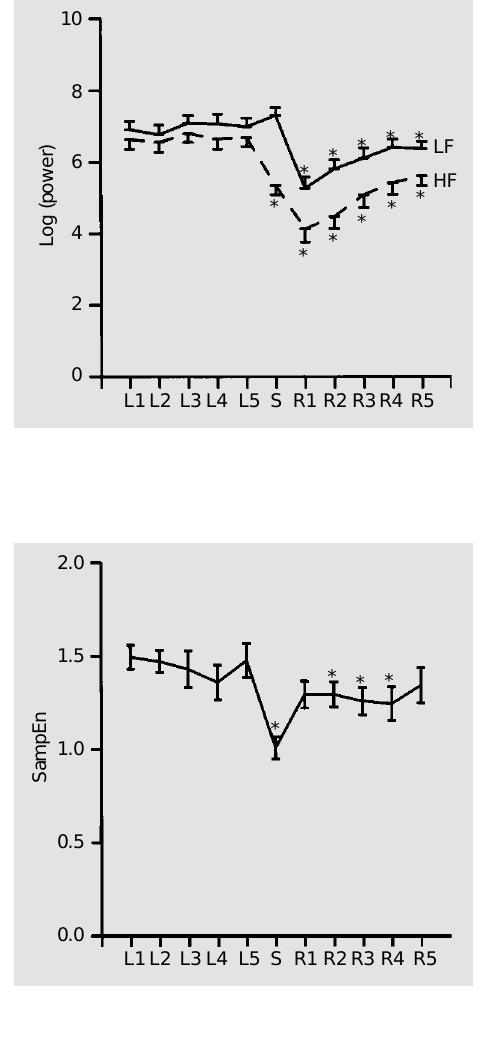
3. Changes of frequency domain heart rate variability indi- ces during the experiment. Data are reported as means and the error bars represent the SEM. *P<0.05 compared to L-phase (repeated measures ANOVA). LF, HF, low and high frequency